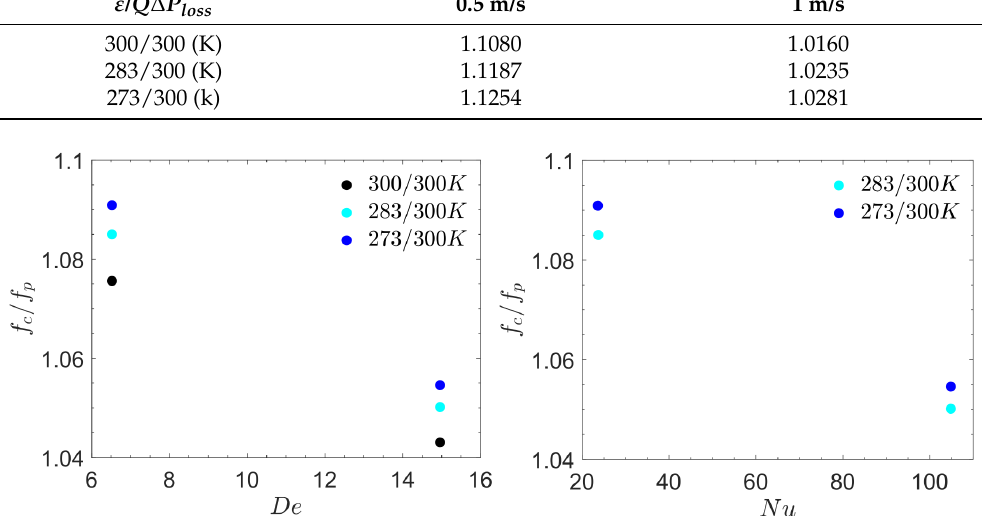
as a function of Dean number at different tempera- as a function of Nusselt number at differ- 𝑓𝑓 𝑐𝑐 / 𝑓𝑓 𝑝𝑝 𝐷𝐷𝑅𝑅 𝑓𝑓 𝑐𝑐 / 𝑓𝑓 𝑝𝑝 𝑁𝑁𝑢𝑢